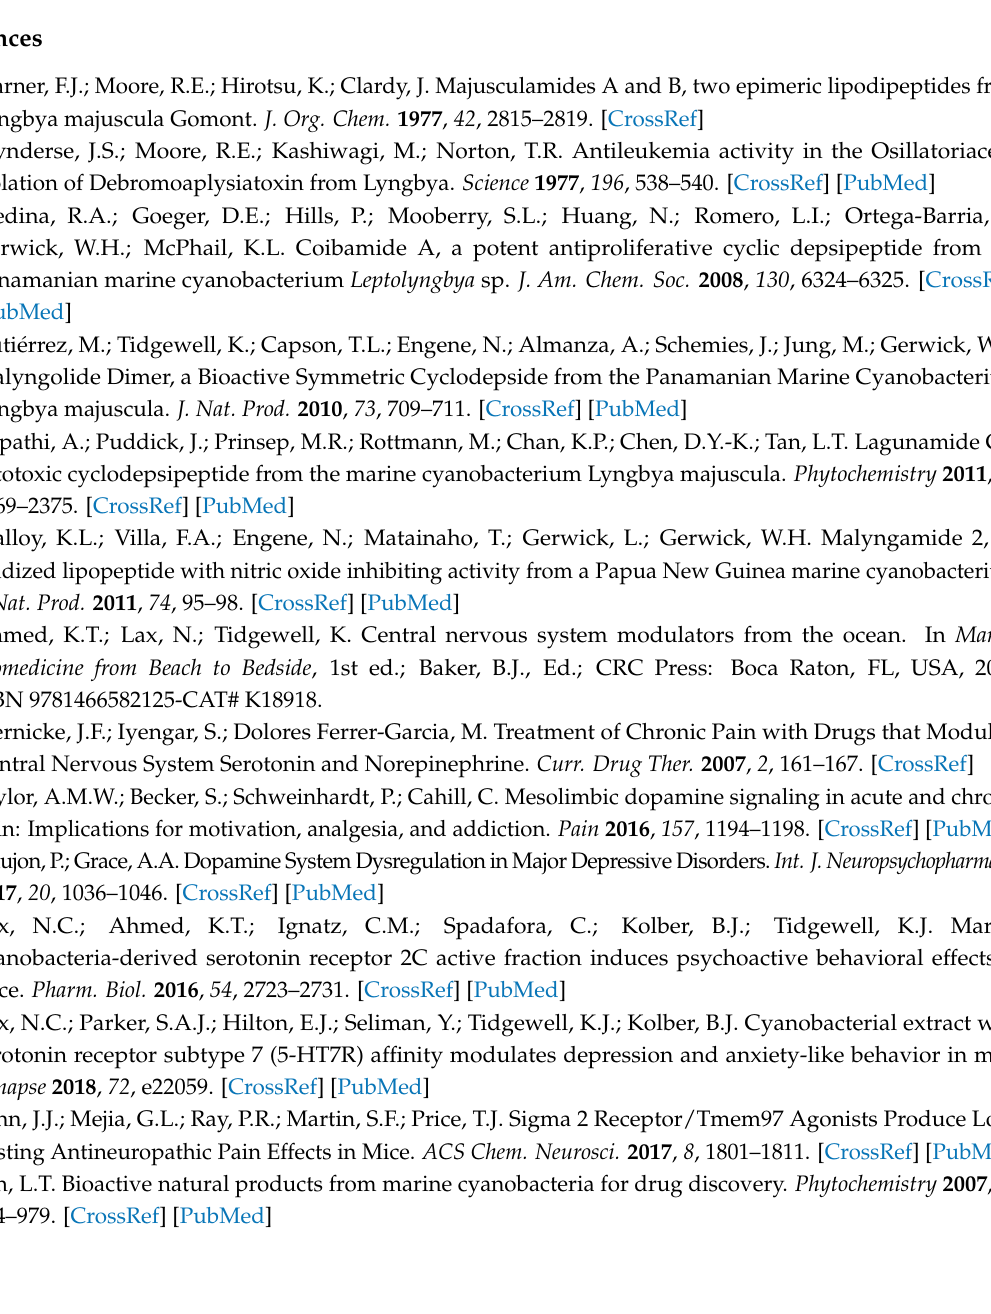
Supplementary Materials: The following are available online. Figure S1: 1H NMR spectrum of compound 2 in CDCl3 at 500 MHz, Figure S2: COSY spectrum of compound 2 in CDCl3 at 500 MHz, Figure S3: HSQC spectrum of compound 2 in CDCl3 at 500 MHz, Figure S4: HMBC spectrum of compound 2 in CDCl3 at 500 MHz, Figure S5: GCMS spectrum of 2